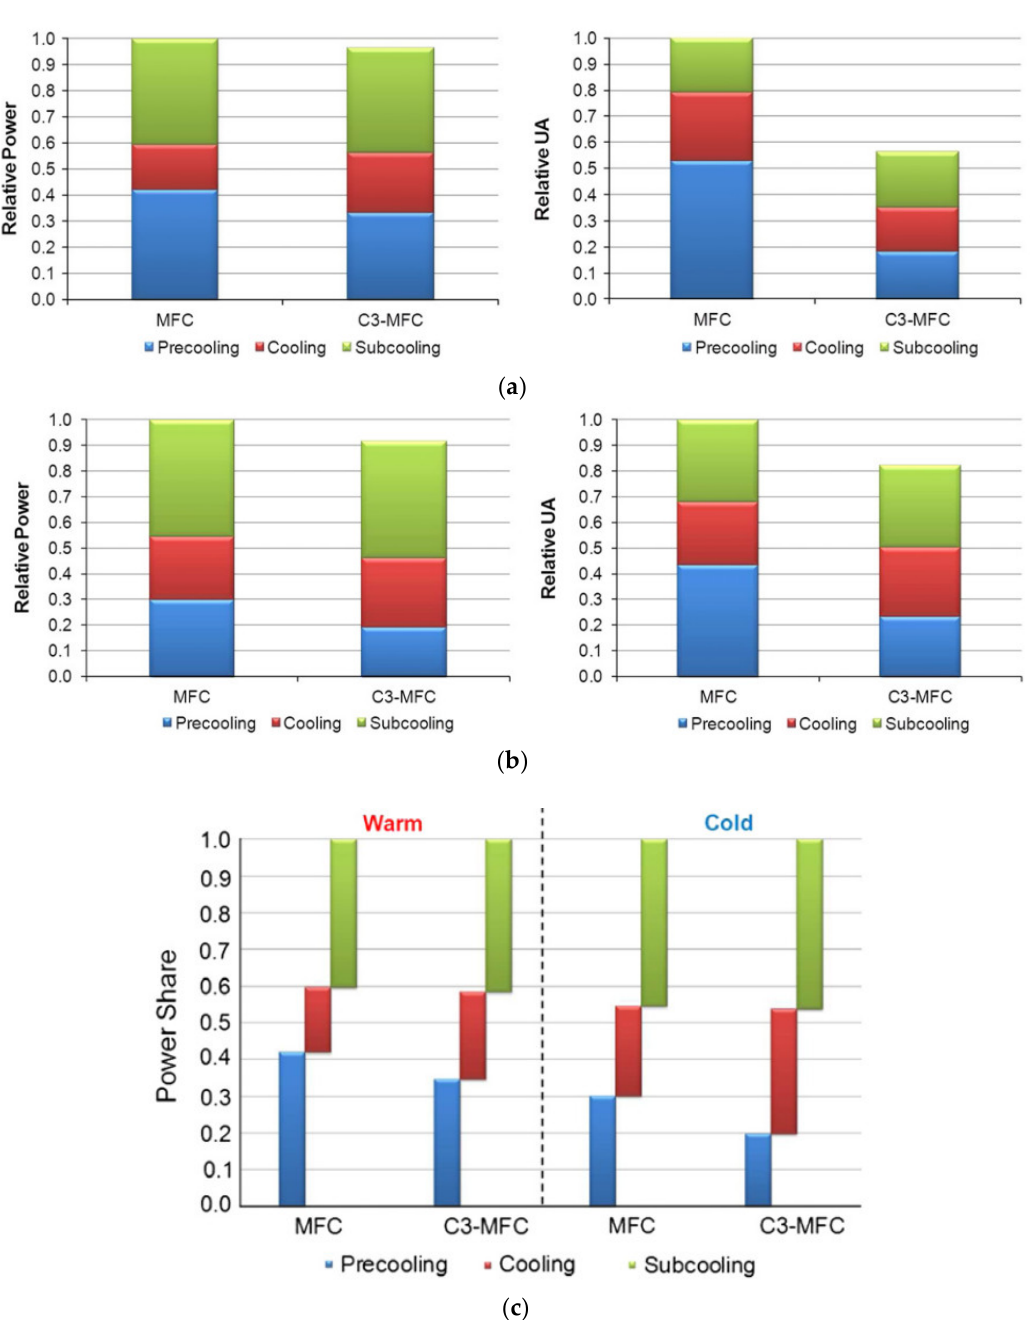
Figure 8. Specific work and power share of studied cases: ( a ) Design variable for the MFC and C3-MFC processes in warm climate. ( b ) Design variable for the MFC and C3-MFC processes in cold climate. ( c ) Power share for the MFC and C3-MFC cases in warm and cold climates [45]. Reproduced with permission from Elsevier (license number